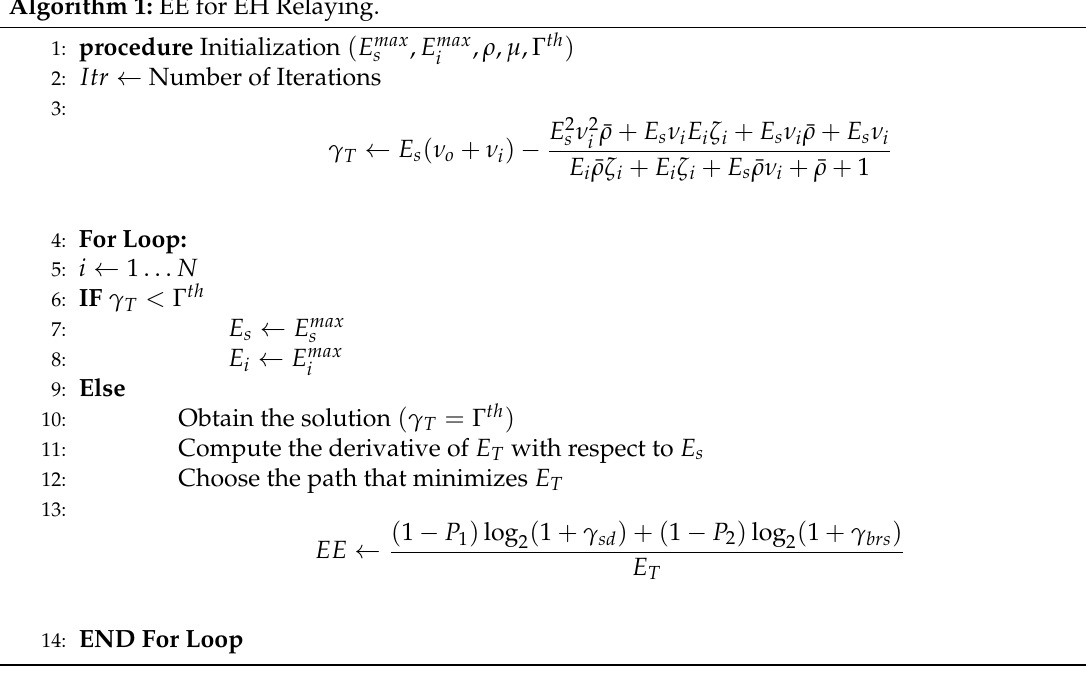
Algorithm 1: EE for EH